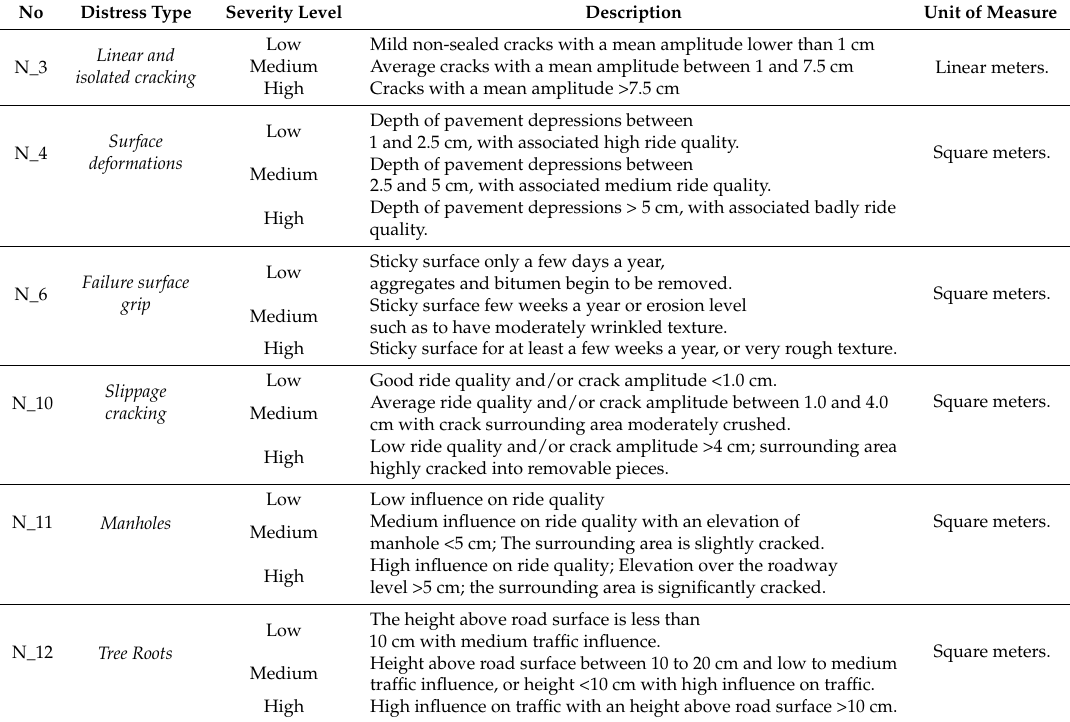
Table 5. Severity levels definitions for urban pavement distresses identification